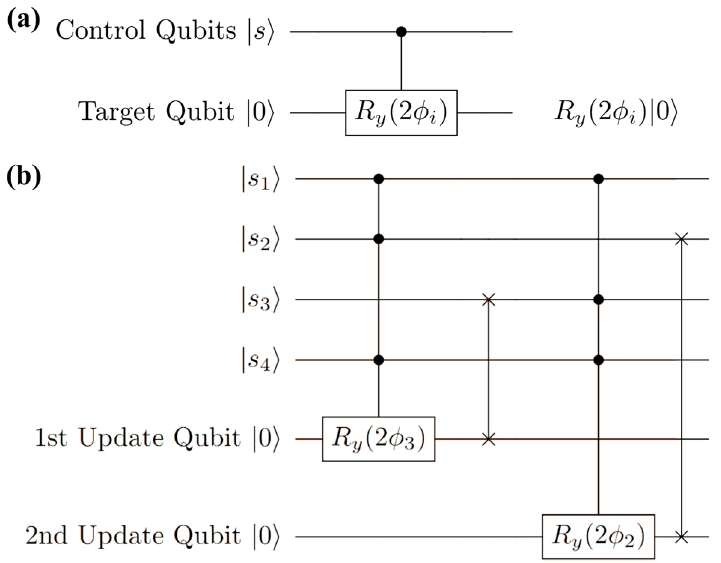
Figure 2. Proposed quantum neuron circuit structure. ( a ) Our proposed quantum neuron for quantum hardware implementation. The full controlled rotation CR y (φ i ) breaks down into sub-rotations dependent on each control qubit as shown in Fig. 1. ( b ) Quantum circuit representing two updates of a selected qubits, s 2 s 3 then . In this case, is updated using the state described by | � | � described by